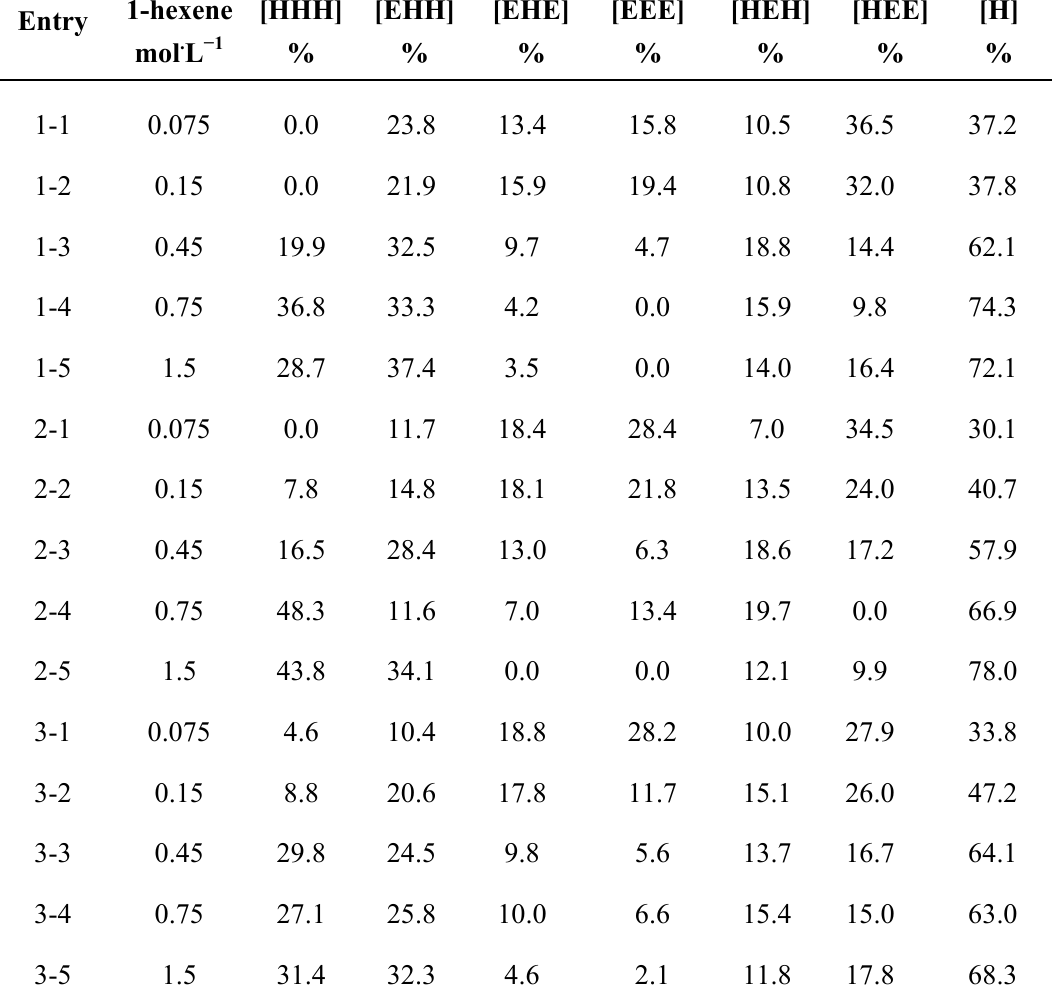
Table 2. Triad distributions of obtained copolymers determined by 13 C NMR